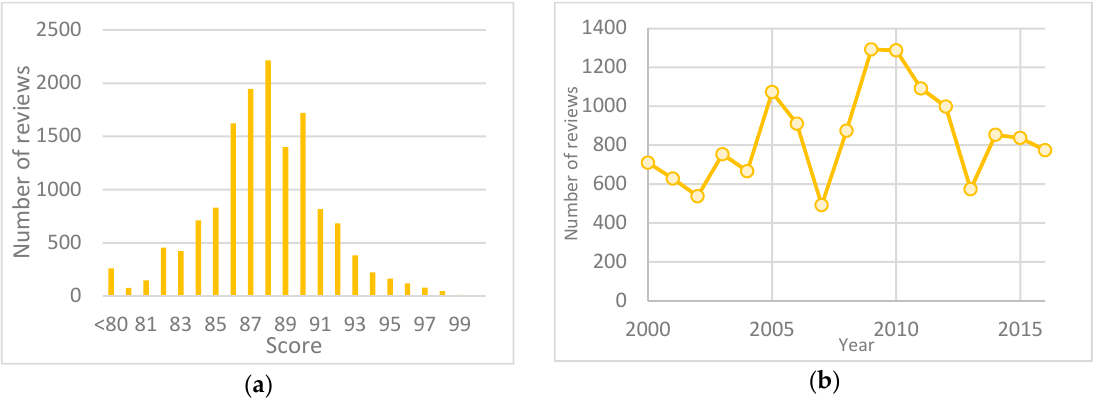
Figure 2. ( a ) The score distribution of ALL Bordeaux Wines; ( b ) The number of wines that have been reviewed annually.